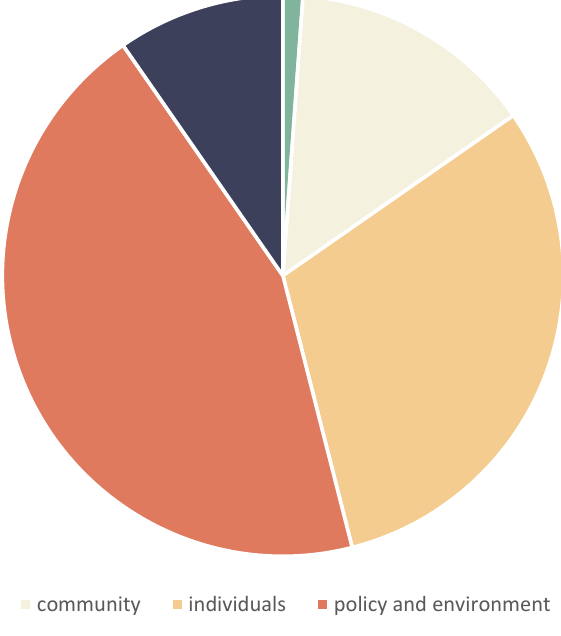
Figure 5. Grey literature according to ecological level.